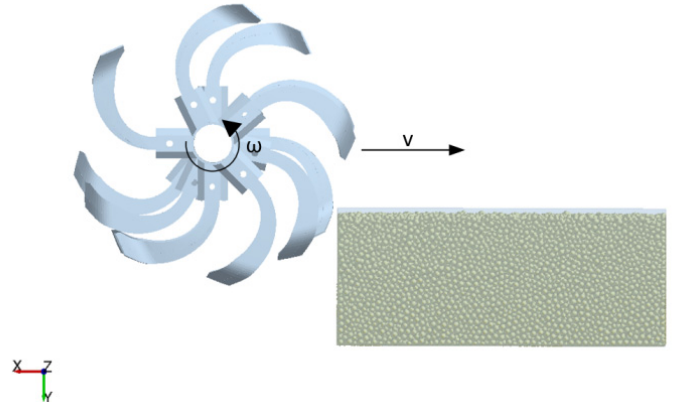
Figure 8. Discrete-element interaction simulation model.